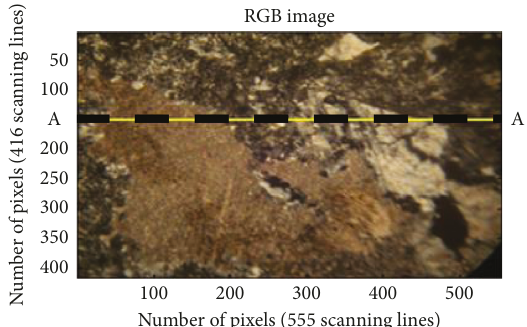
Figure 2: The original image with the j-coordinates at i (section AA).